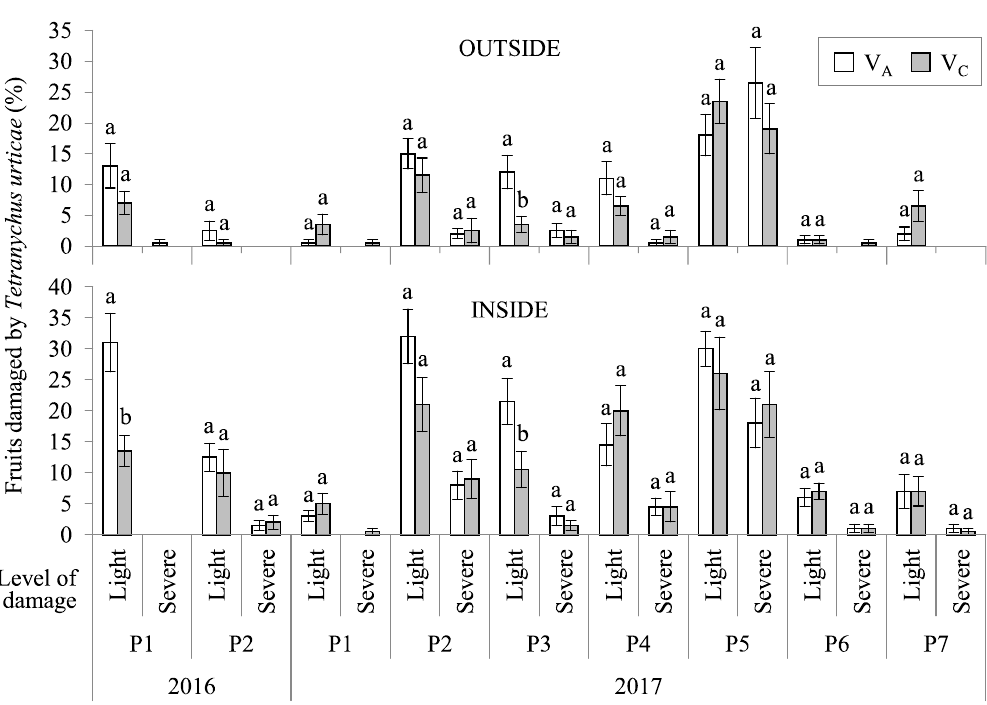
Figure A3. Fruits damaged by Tetranychus urticae (%, mean ± standard error) per treatment (V A : adjusted volume, V C : conventional volume), at two depths of the canopy (outside, inside) and in different plots (P1–P7) and years (2016 and 2017). Different letters above the bars indicate significant differences (LSD test, p < 0.05).